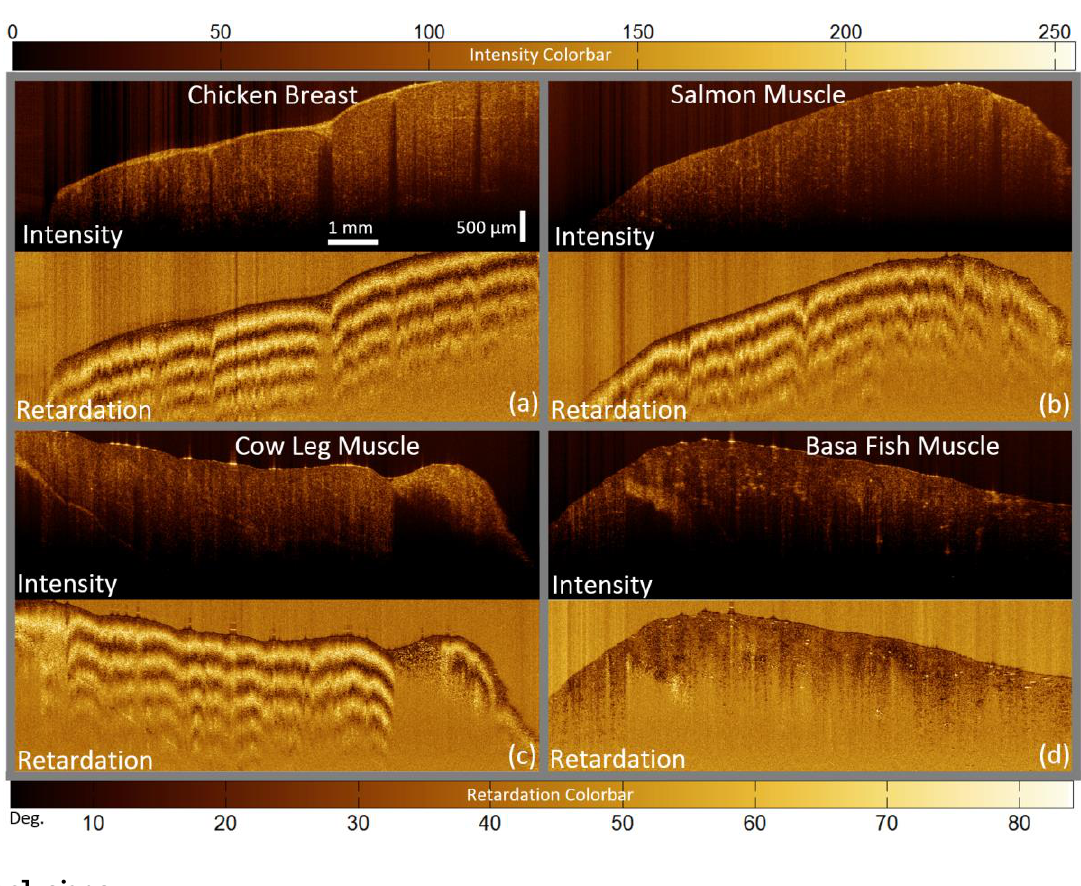
Figure 4. PSOCT imaging of muscle samples; Intensity and retardation of ( a ) chicken breast, ( b ) salmon, ( c ) cow leg, and ( d ) basa fish muscle samples